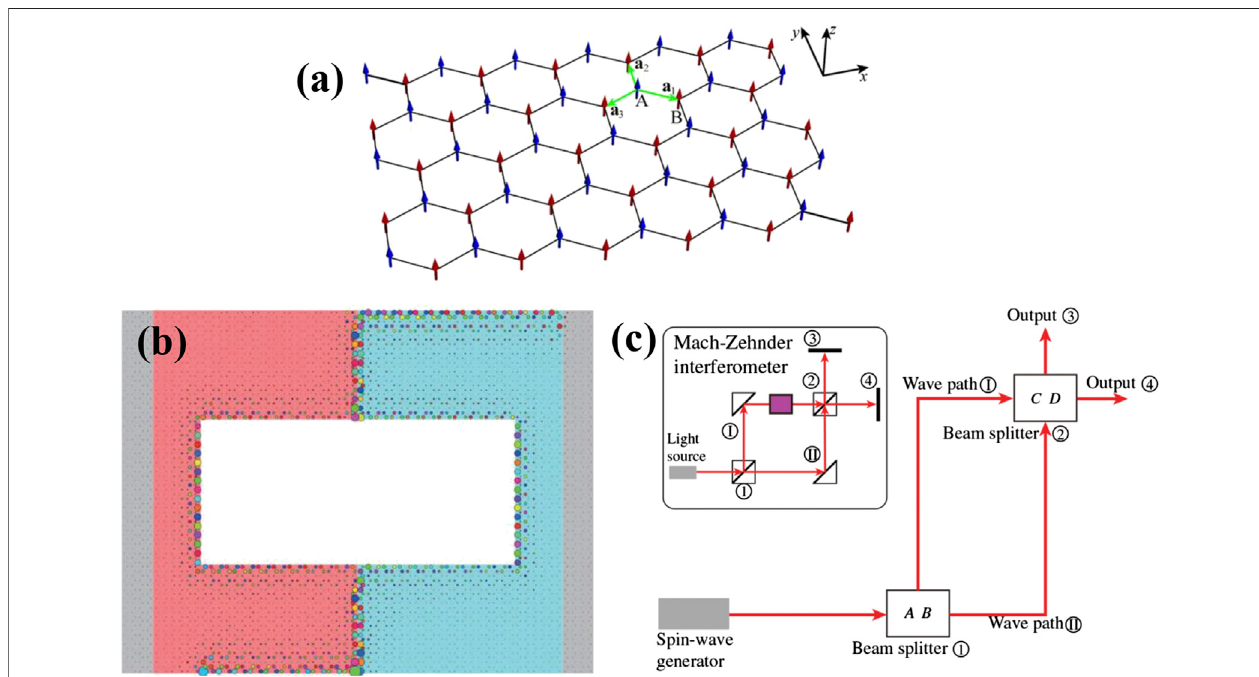
FIGURE1|(A) SchematicdiagramofperpendicularlymagnetizedferromagnetwithahoneycomblatticeforpropagatingTESWs.Theblueandredarrowsindicate the magnetic moment vectors on sublattices A and B. Green arrows are three adjacent site vectors a 1 , a 2 and a 3 (Wang et al., 2017). Reproduced with the permission from https://journals.aps.org/prb/abstract/10.1103/PhysRevB.95.014435. (B) TESWs interferometer, in which spin waves propagate or split along the domain walls, where the length of propagation path determines the phase and amplitude of spin waves (the size of different color symbols). In this setting interference occurs, where two spin waves with different phases are merged (Wang et al., 2018c). Reproduced with the permission from https://journals.aps.org/prapplied/abstract/10. 1103/PhysRevApplied.9.024029. (C) Schematic diagram of TESWs interferometer in (B) , the illustration is optical Mach-Zehnder interferometer and a beam enters beam splitter ① and gets divided into two beams, and the two beams are recombined at the second beam splitter ② , and the outputs ③ and ④ depend on the interferenceresultofthetwobeamsatbeamsplitter ② (Wangetal.,2018c).Reproducedwiththepermissionfromhttps://journals.aps.org/prapplied/abstract/10.1103/